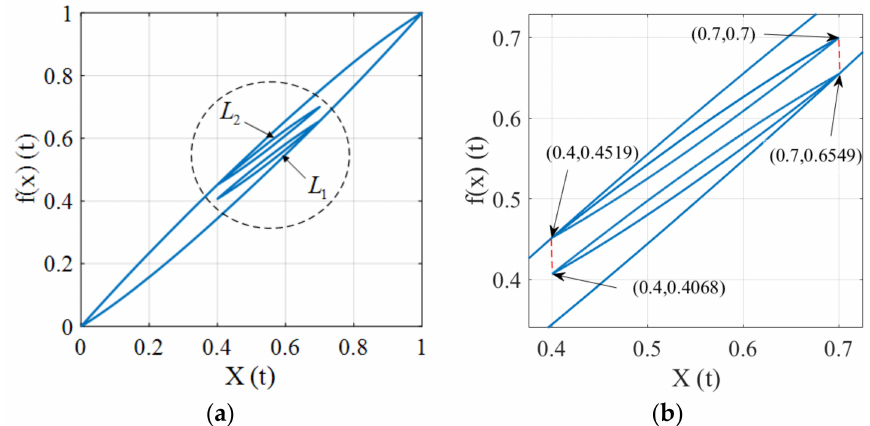
Figure 9. Illustration of the congruency property for the hysteresis operator. ( a ) Hysteresis trajectory. ( b ) An enlarged view of the circle area.